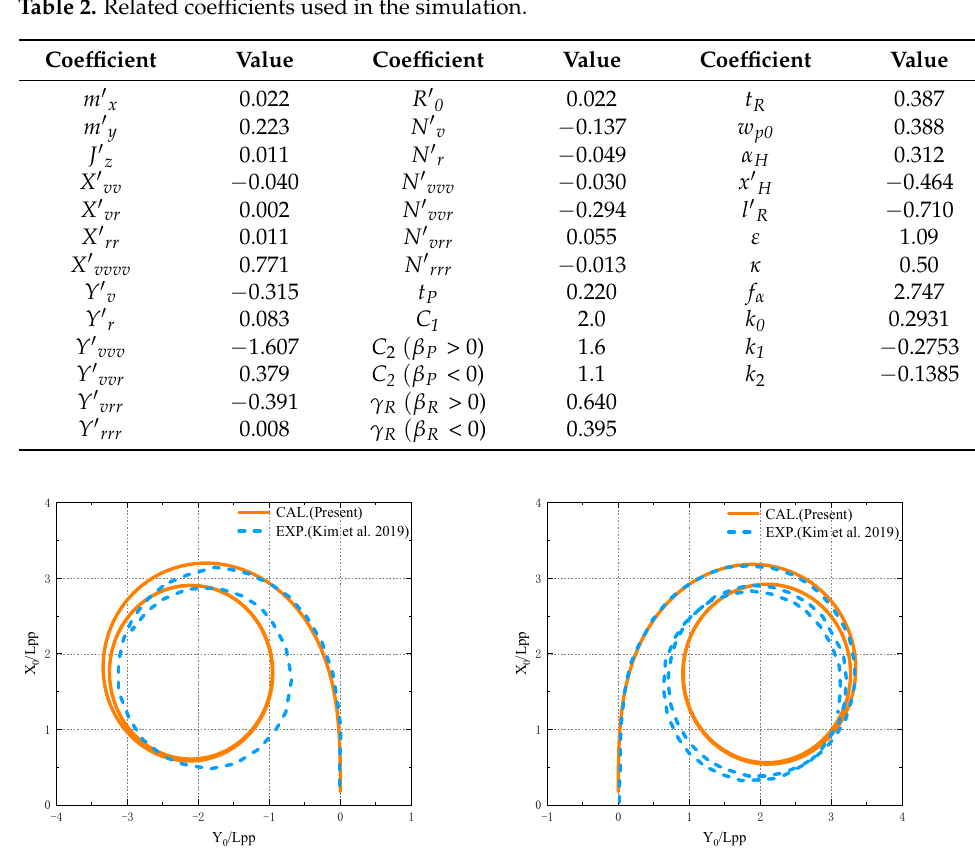
Figure 19. Comparison of the turning trajectory of the KVLCC2 model with δ = ±35° in calm water. The experimental values were reproduced from [8], with permission from Elsevier, 2022.